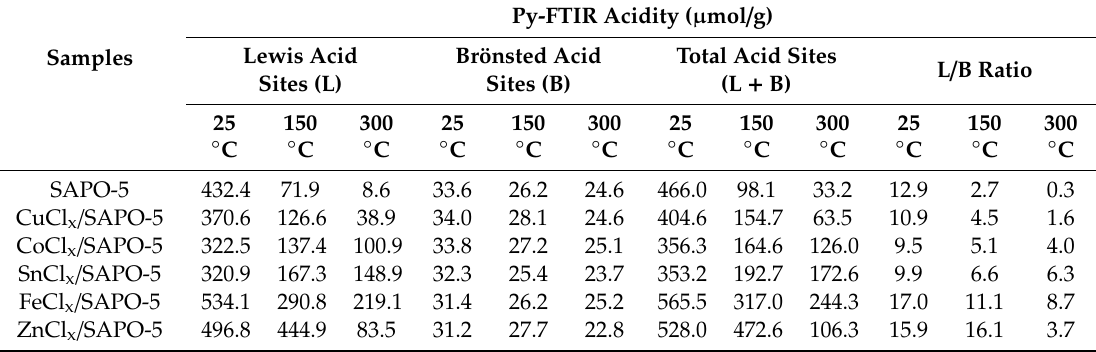
Table 4. Surface acidity of MCl x / SAPO-5 measured using pyridine (Py) adsorption coupled with FTIR spectroscopy